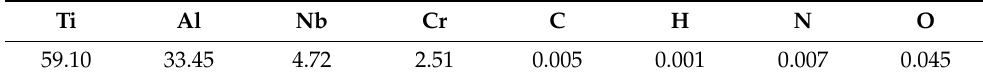
Table 1. Ti48Al2Cr2Nb chemical composition (wt%) from